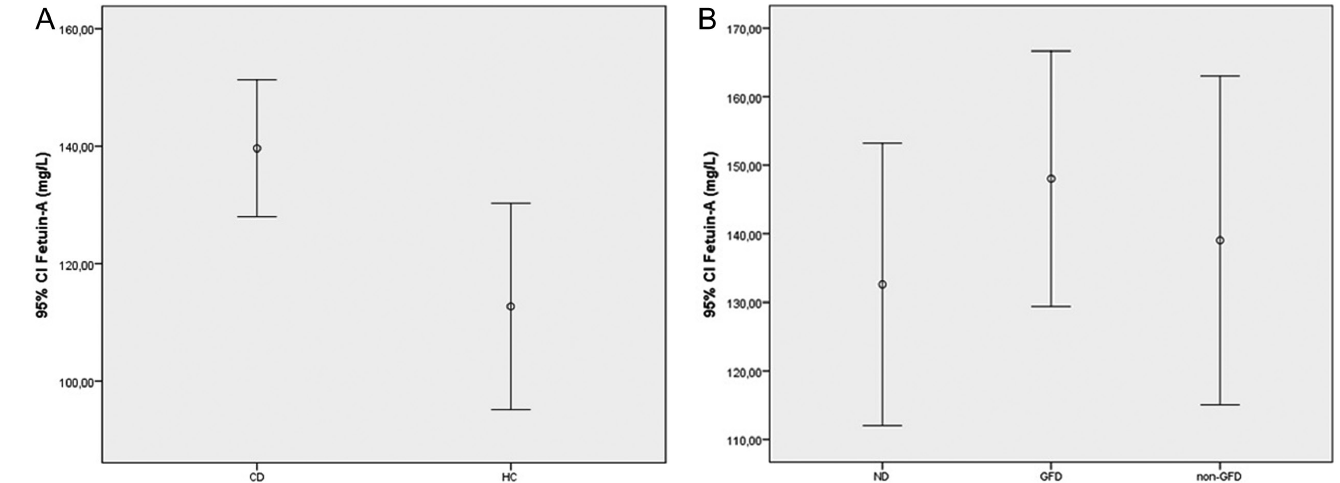
Figure 1. Serum Fetuin-A levels in patient and healthy control group (A), Serum Fetuin-A levels in celiac subgroups